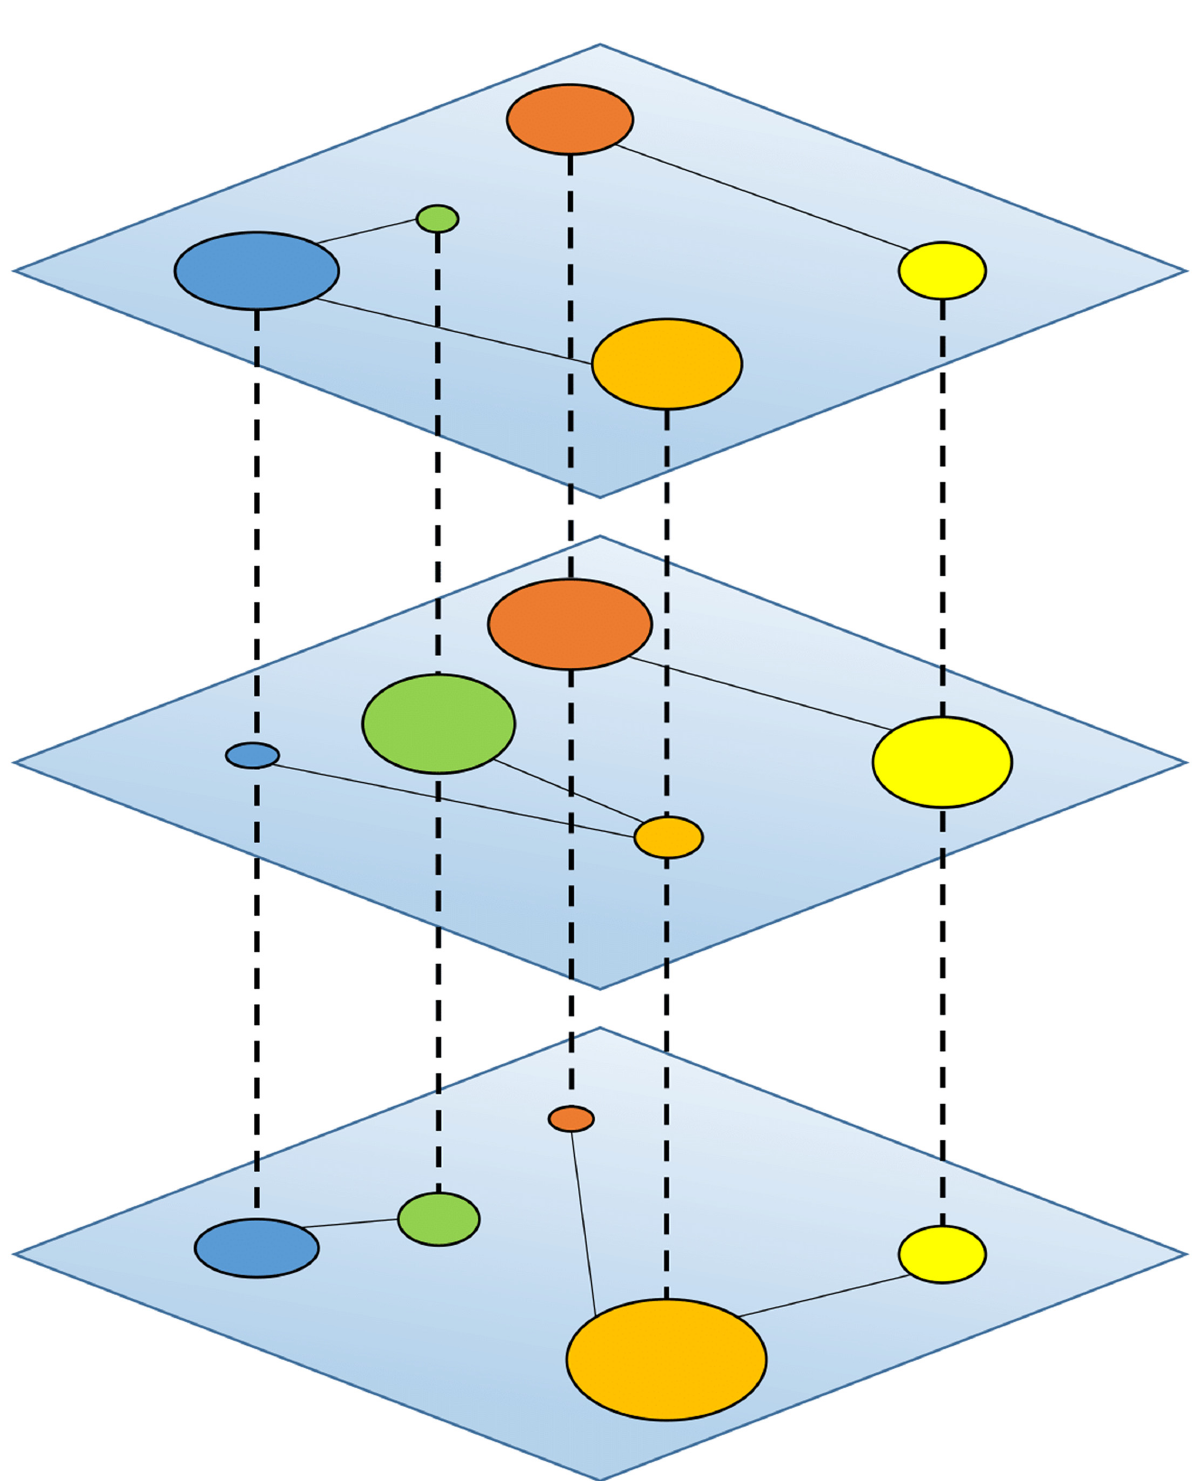
Fig 1. Schematic example of a multiplex network. The multiplex is made of N = 5 nodes embedded within M = 3 layers, each one containing 3 links. The size of nodes is proportional to centrality measure. The dashed lines represent interlayer connections, while the continuous lined represent the intra-layer